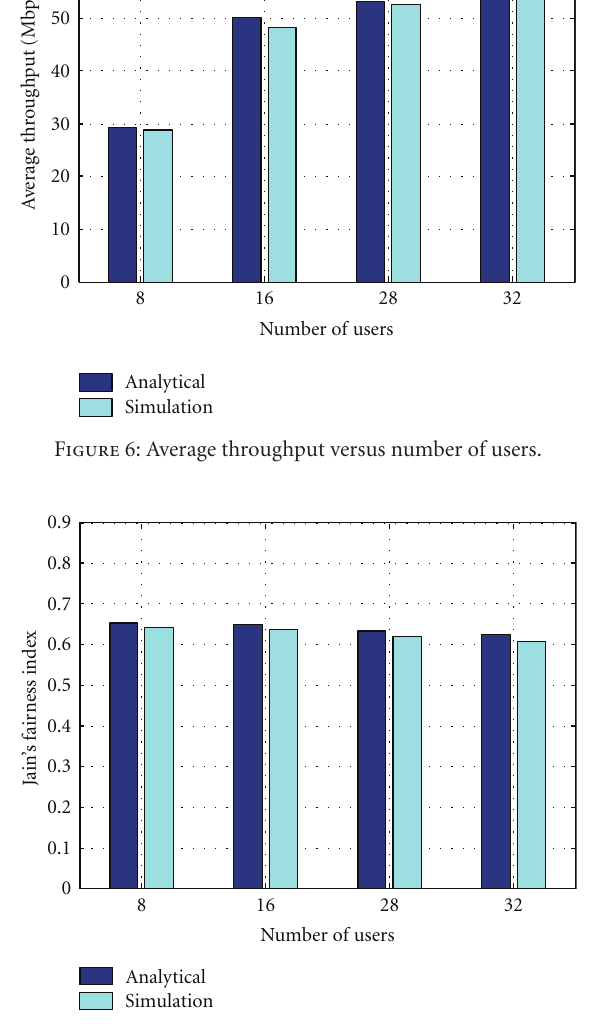
Figure 7: Jain’s fairness index versus number of users.